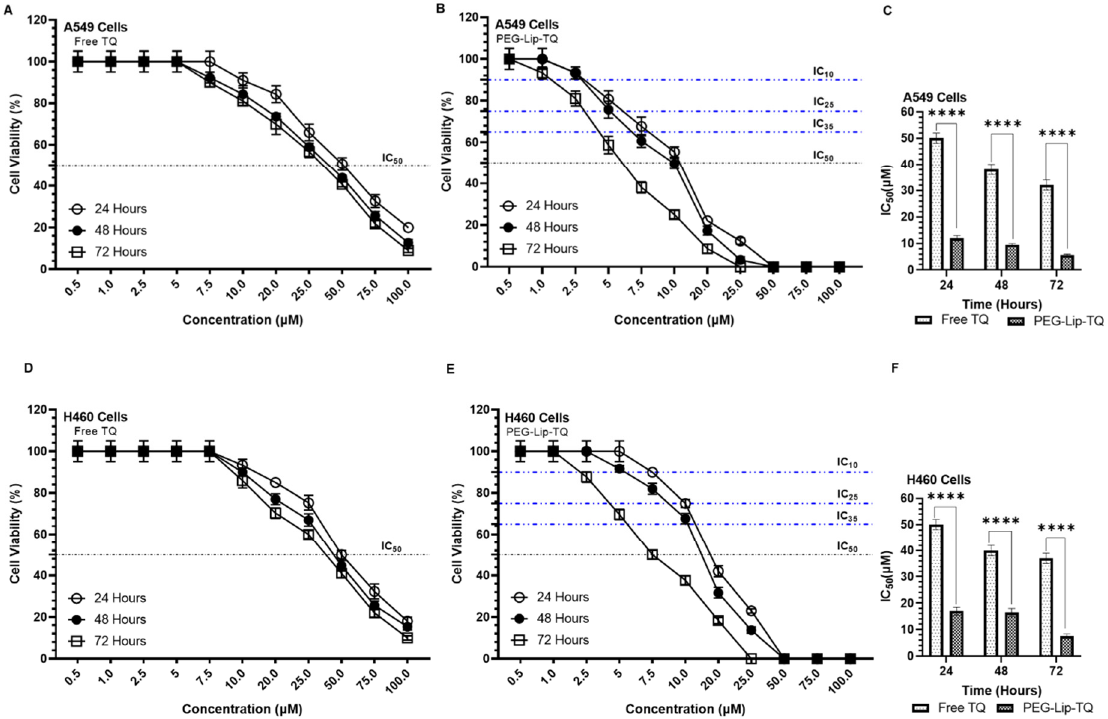
Figure 6. Effect of TQ at varying concentrations on cellular proliferation by cell cytotoxicity assay at 24, 48, and 72 h in A549 and H460 lung cancer cell lines. ( A ) Free TQ, ( B ) PEG-Lip-TQ, ( C ) IC 50 of Free TQ, and PEG-Lip-TQ in A549 lung cancer cells, ( D ) Free TQ, ( E ) PEG-Lip-TQ, ( F ) IC 50 of Free TQ, and PEG-Lip-TQ in H460 lung cancer cells. The values are expressed as mean ± SE of three independent experiments. **** Significant difference between the treated groups, p -value < 0.0001.